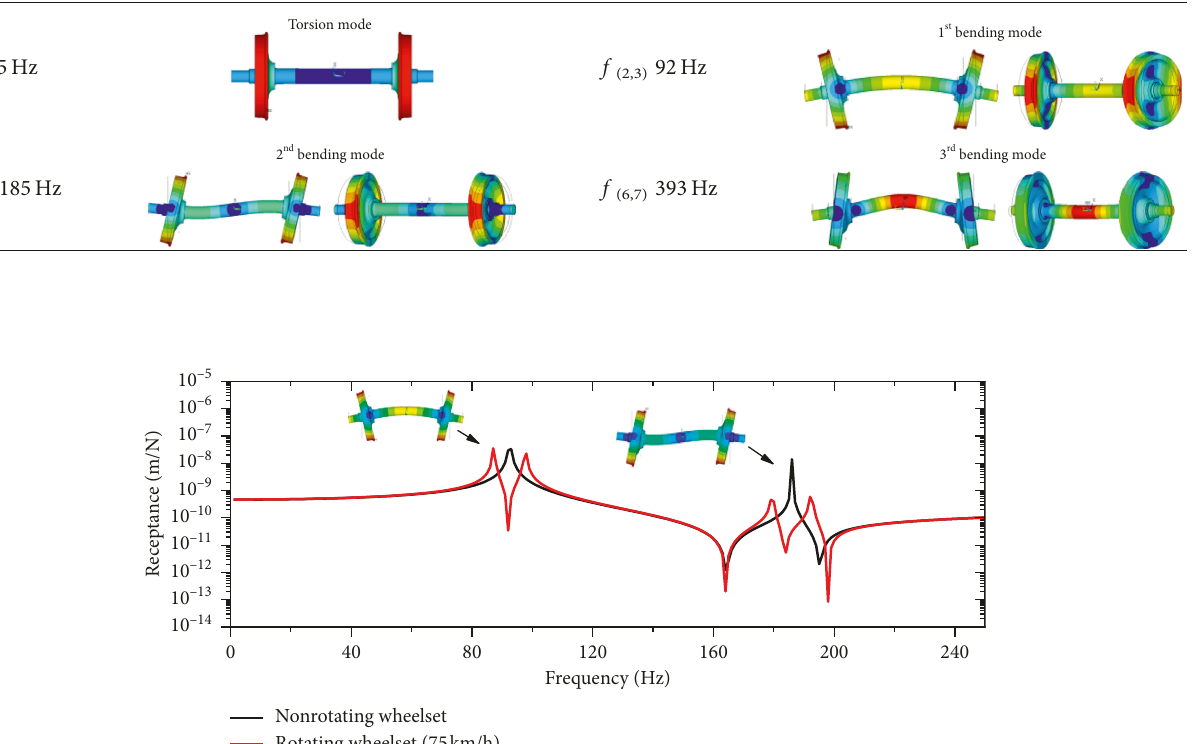
Figure 18: Vertical receptance at the nominal contact point of the flexible wheelset when the velocity of the wheelset is 0 and 75 km/h.